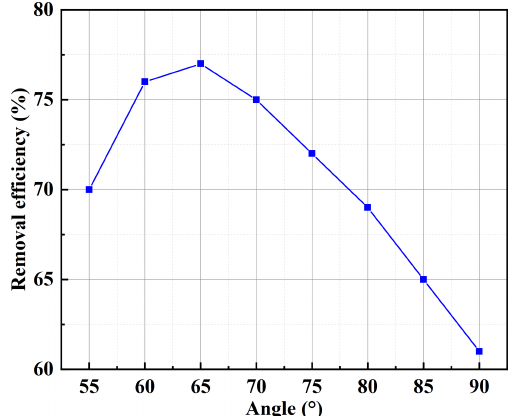
Figure 6. Effect of the outlet diameter on the efficiency of dust